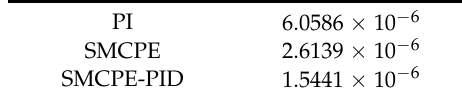
Figure 9. ( a ) Position PI vs. SMCPE, ( b ) Position error PI vs. SMCPE, ( c ) Position error SMCPE vs. SMCPE–PID, ( d ) Position–reference PI vs. SMCPE, ( e ) Position–reference SMCPE vs. SMCPE–PID, ( f ) Control signal PI vs. SMCPE, and ( g ) Control signal SMCPE vs. SMCPE–PID. Table 4. IAE performance indicators for sinusoidal signal.